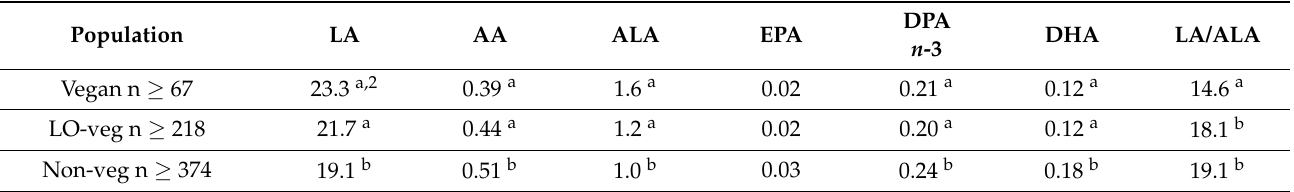
Table 5. Adipose tissue fatty acids in vegans, lacto-ovo vegetarians and non-vegetarians (% total fatty acids) 1